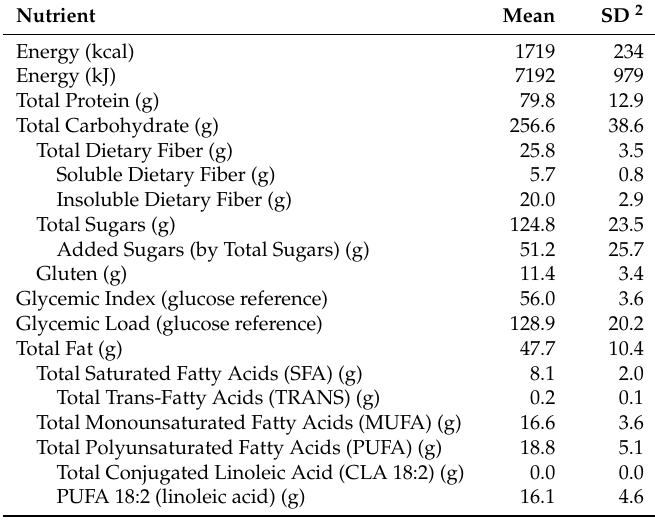
Table 3. Calculated energy, macronutrient and related components 1 for seven-day low saturated fat Swank menus without dietary